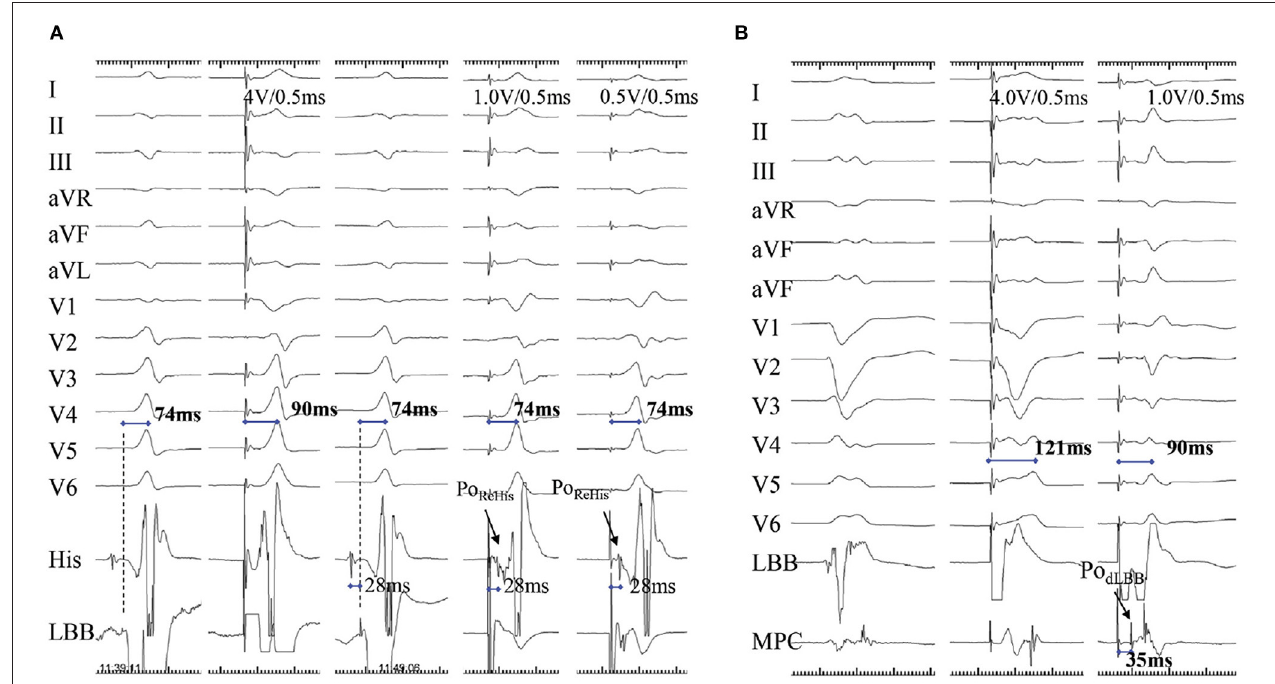
FIGURE 5 | A demonstration of direct LBB capture using retrograde His potential and anterograde distal left conduction system potential. (A) A case with narrow QRS wave. There is a small Po LBB and long pLVAT (90ms) with septal pacing (first two beats). When the lead is advanced at a deeper site of septum, the non-selective and selective LBBP (last three beats) are visible, with larger Po LBB , shorter and constant pLVAT (74ms), and Po Rehis with stimulus to Po Rehis interval of 28ms at low and high outputs. (B) The Po dLBB can be recorded after the ventricular EGM with MCP distal to the LBBP lead (first beat). The second beat shows the Po dLBB remains after the ventricular EGM with 121ms pLVAT during septal pacing, whereas the last indicates achievement of selective LBBP at a deeper site, Po dLBB recorded ahead of ventricular EGM with shorter pLVAT (90ms) ( 9). LBB, left bundle branch; pLVAT, peak left ventricular activation time; LBBP, left bundle branch pacing; MCP, multipolar placed; EGM, electrogram; Po dLBB , distal left bundle branch potential; Po Rehis , retrograde His